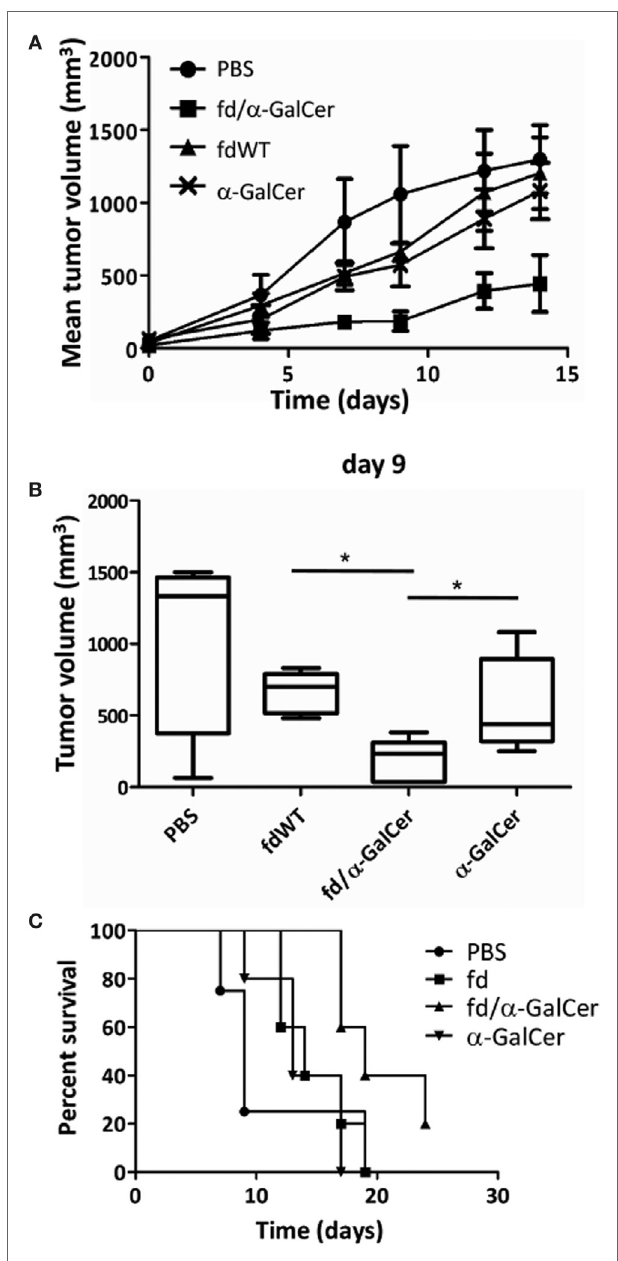
FigUre 5 | Therapeutic vaccination with filamentous bacteriophages fd/ alpha-GalactosylCeramide ( α -GalCer) is protective against a subcutaneous tumor challenge. C57BL/6 mice ( n = 5/group) were engrafted with B16 melanoma cell line and when tumor was palpable, mice were injected two times subcutaneously into the tumor with phosphate buffered saline, free α -GalCer, fdWT, or fd/ α -GalCer. (a) The chart shows the mean tumor size reached in each group. (B) Tumor volumes recorded at 9th day after vaccination are reported as box plot, showing the group median, quartiles, and extreme values. Median values are represented by the horizontal line. * p < 0.05 by one-way ANOVA followed by a Dunnett’s multiple comparison test. (c) Kaplan–Meier survival curves of B16-engrafted mice during the experiment. Differences among survival curves of α -GalCer-treated and fd/ α -GalCer-treated mice are statistically different ( p < 0.01) by log-rank (Mantel–Cox)